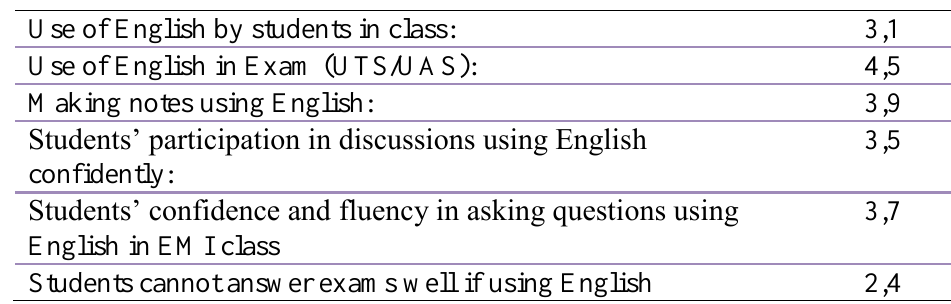
Table 7.Students’ Use of English in Classroom